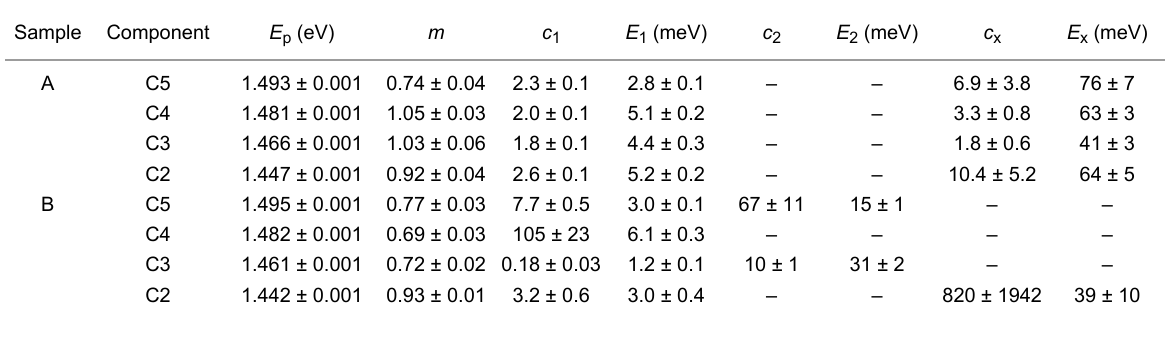
Table 2: Values of the peak energy ( E p ), measured at 6 K, of the Gaussian components for the two samples, and parameters estimated from the fitting of Equation 4 and Equation 6 to the experimental data.